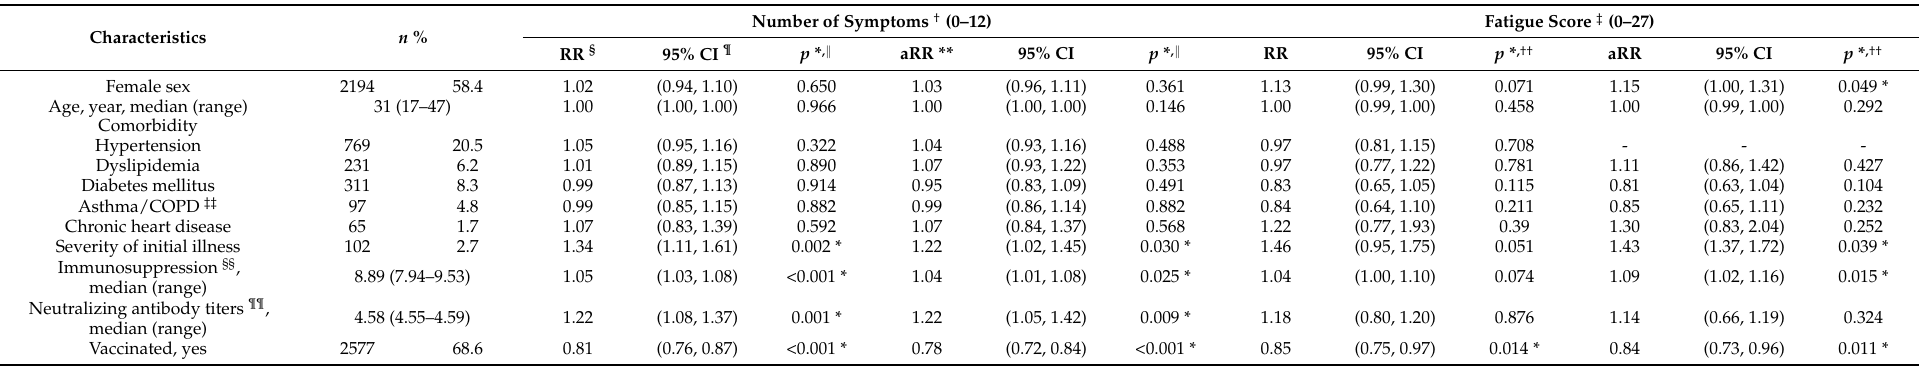
Table 3. COVID-19 patient factors associated with increasing number of symptoms and higher fatigue score at 14-day follow-up—negative binomial mixed models (July 2021 to March 2022)